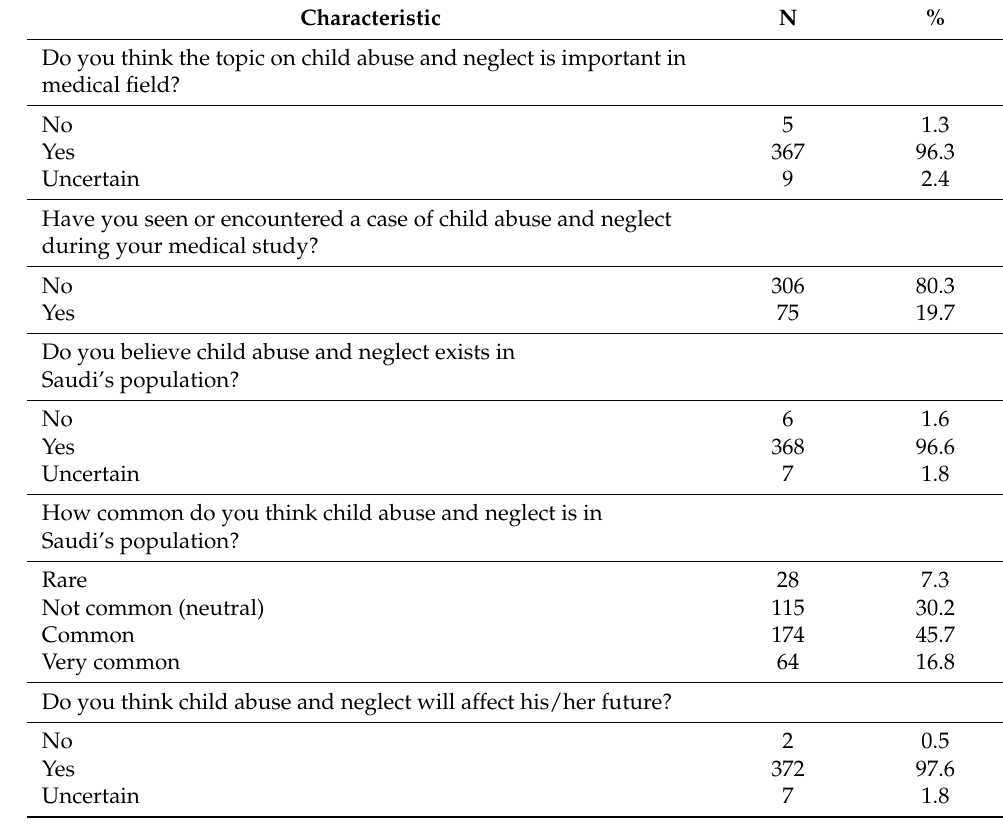
Table 2. Participant’s Opinion on the Importance and the Level of Prevalence of Child Abuse and Neglect in Saudi Population. Characteristic N